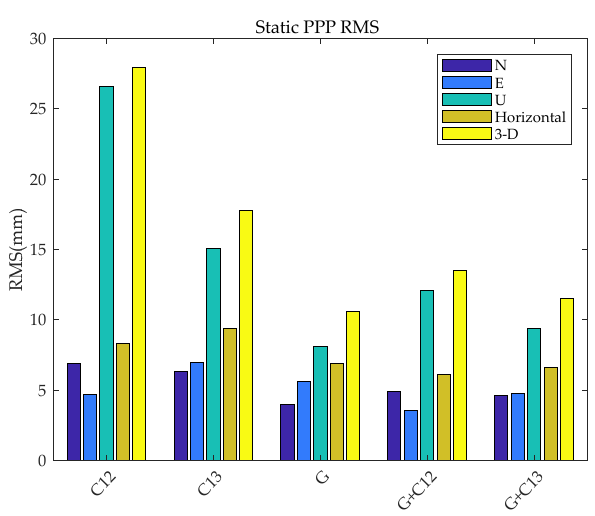
Figure 7. Static PPP positioning accuracy histogram.